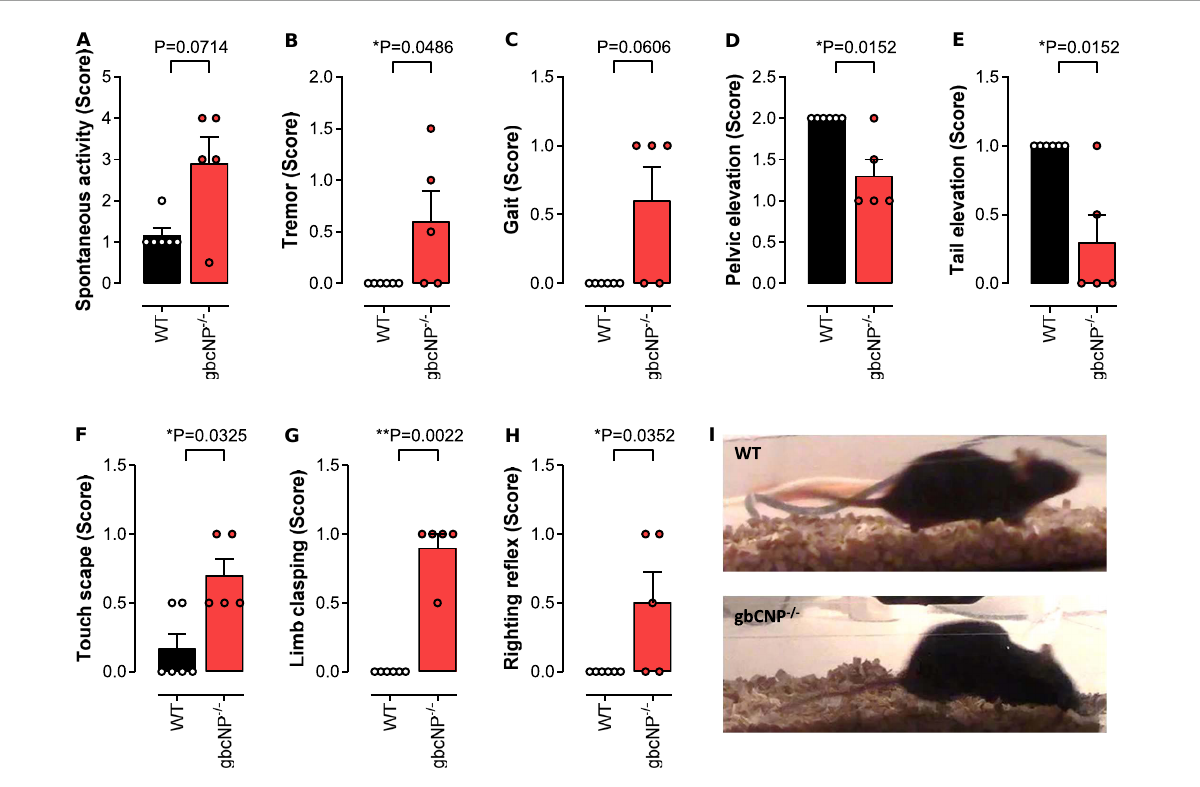
FIGURE5 Abnormal gait, motor and sensory function in aged gbCNP - / - mice. Primary screen of SHIRPA in aged (65 weeks) wild type (WT) and global CNP knockout (gbCNP - / - ) mice. Spontaneous activity (A) , tremor (B) , gait (C) , pelvic elevation (D) , tail elevation (E) , touch scape (F) , limb clasping (G) , righting reflex (H) , and representative images of WT and gbCNP - / - mice (I) . n = 5. Statistical analysis by two-tailed Student’s t-test. Each statistical comparison undertaken has an assigned P value (adjusted for